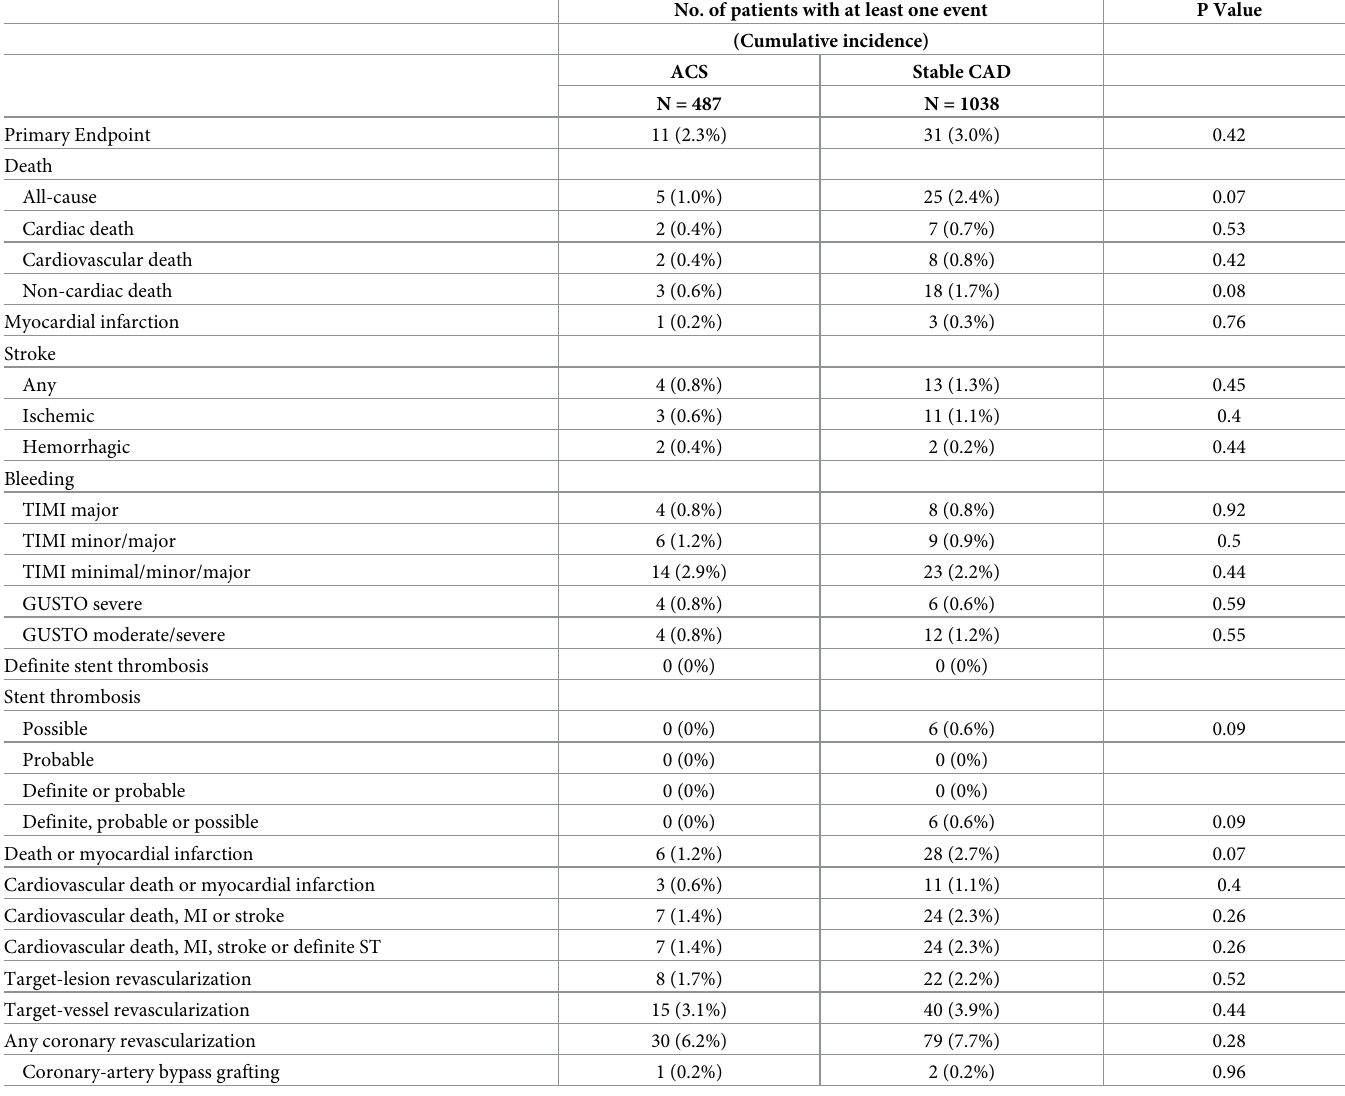
Table 2. Clinical outcomes at 12-month.